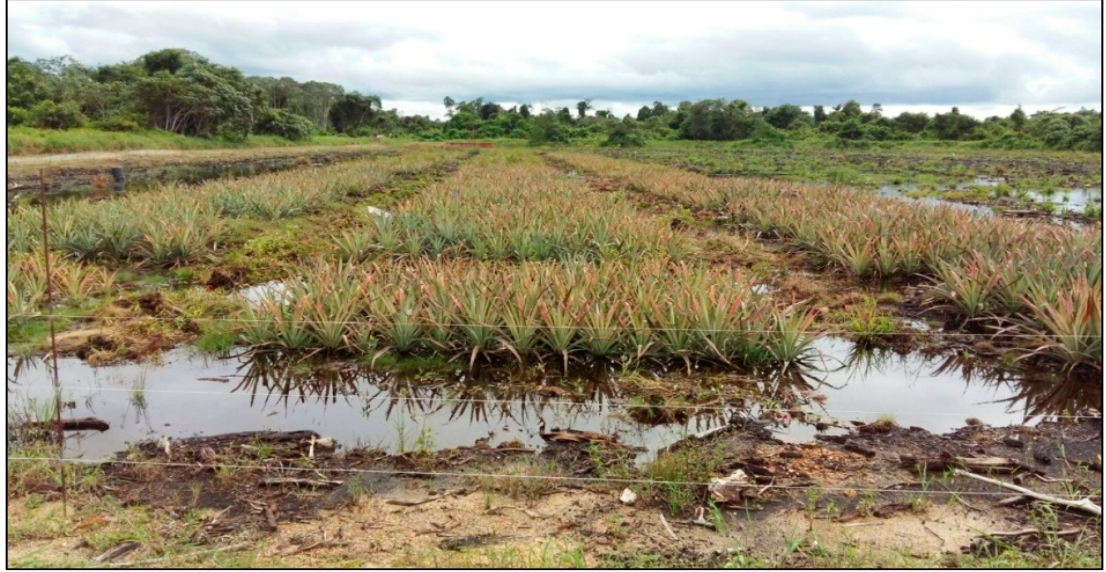
Figure 2. Study site of peatland cultivated with Ananas comosus.